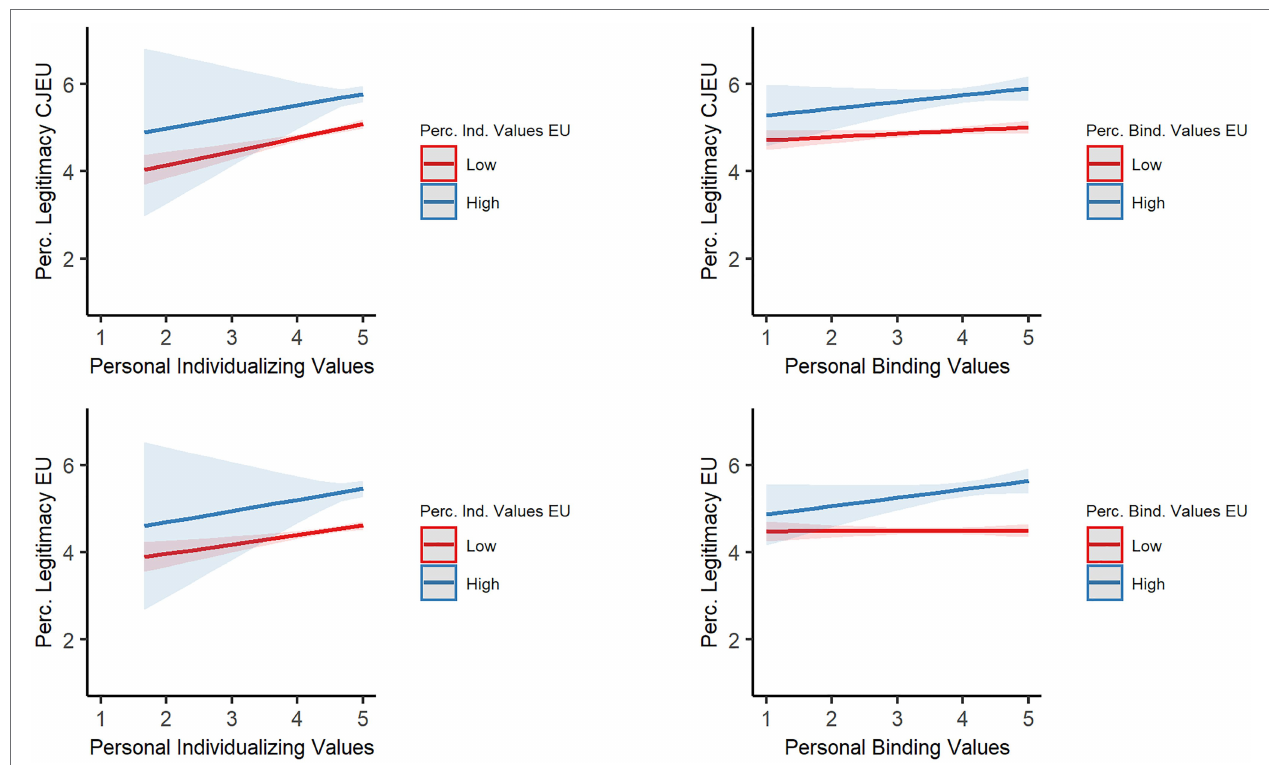
FIGURE 3 | Slopes of the interaction between personal values and perceived values of the EU on perceived legitimacy of the CJEU and